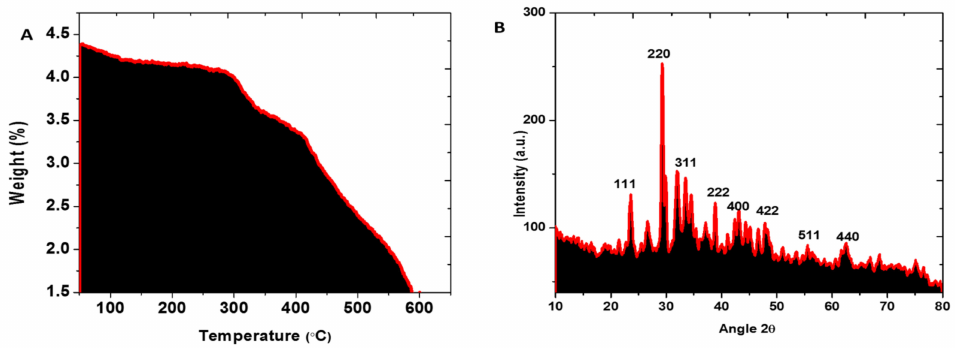
Figure 3. ( A ) TGA micrograph of Enterobacter strain G52 extract mediated FeNPs and ( B ) X-ray diffraction pattern of